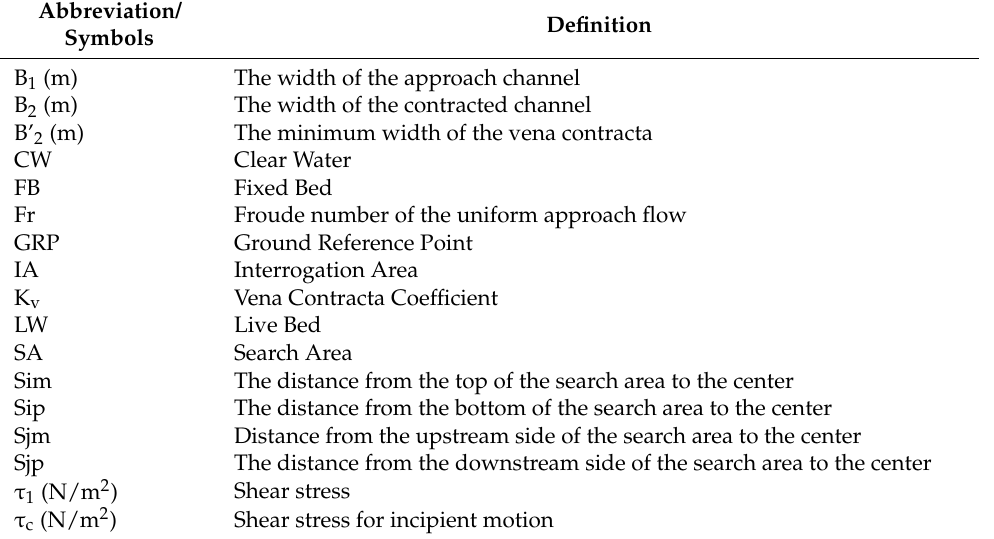
Table 1. Abbreviation table.